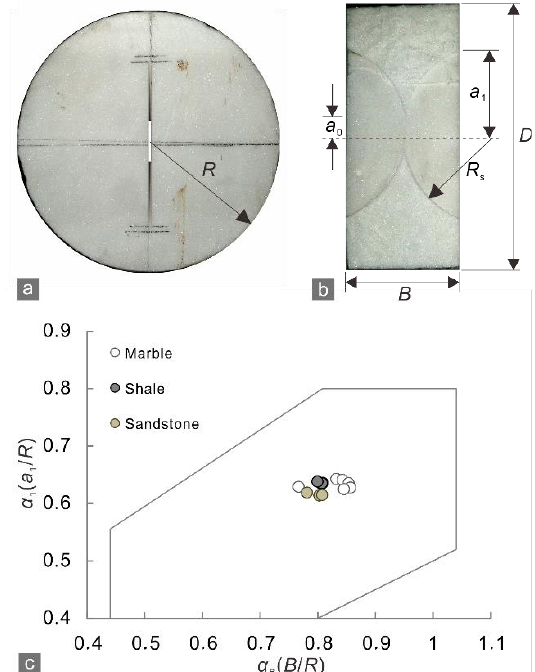
Figure 2. ( a ) Orthographic and ( b ) side profiles of a marble CCNBD specimen; ( c ) valid range for dimensionless parameters α 1 and α B (outlined in gray) [23] and the distribution of parameter values for all of the prepared CCNBD specimens. Geometric parameters: diameter D = 75 mm, radius R = 37.5 mm, thickness B = 30 mm, saw radius R s = 25 mm, initial chevron notched crack length a 0 = 8.45 mm, and final chevron notched crack length a 1 = 23.5 mm.